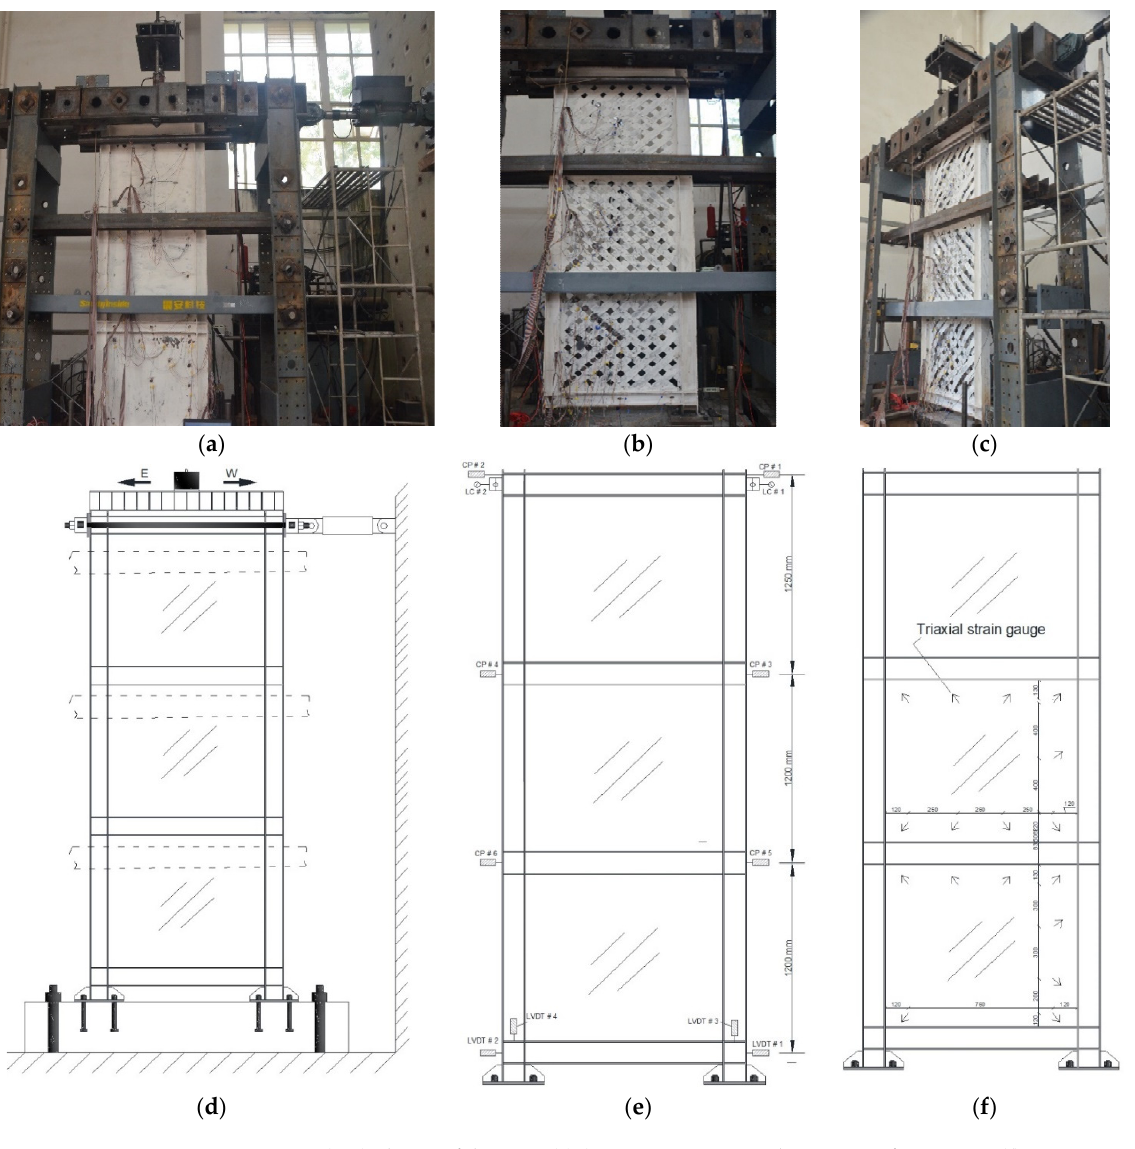
Figure 4 . ( a – c ) photos of the tests, ( d , e ) Test setup, CPs, and LVDTs configurations, ( f ) strain gauge details.